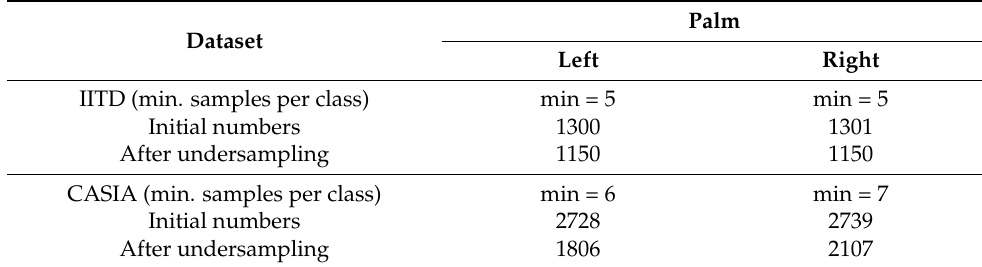
Table 2. The amount of data before and after the application of the undersampling procedure on the two experimental